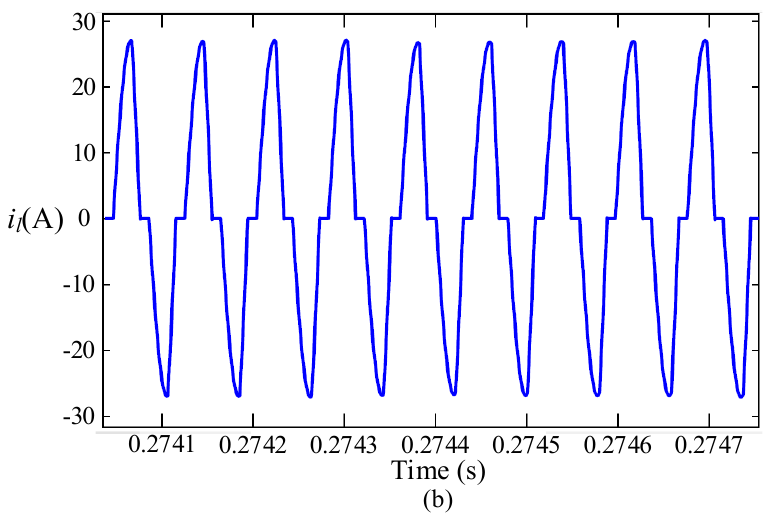
Figure 9. Zoom-in waveforms of ( a ) resonant capacitor voltage V c and ( b ) resonant inductor current i l . The waveforms of the output voltage of the full bridge U ab , inductor current i l , and capacitor voltage V c across the tank are presented at 0.15 duty cycle ( V i = 80 V and V o = 50 V) in Figure 10. The duty cycle is raised to 0.7 ( V o = 160 V) in Figure 11. In both figures, the current returns and stays at zero until the beginning of a new switching mode, which operates in discontinuous conduction mode (DCM). The results support the precise anticipation of current and voltage in Sections 2 and 3, whereas the boundary conditions are achieved at the derived turns ratio and the resonance frequency. In both cases, the output current i o is fixed at Figure 9a.